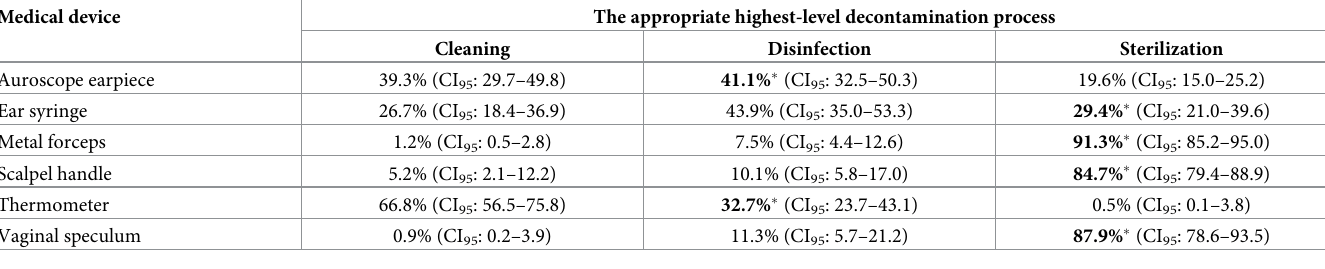
Table 6. Participants’ opinion on the highest level of decontamination appropriate for reusable medical devices. Medical